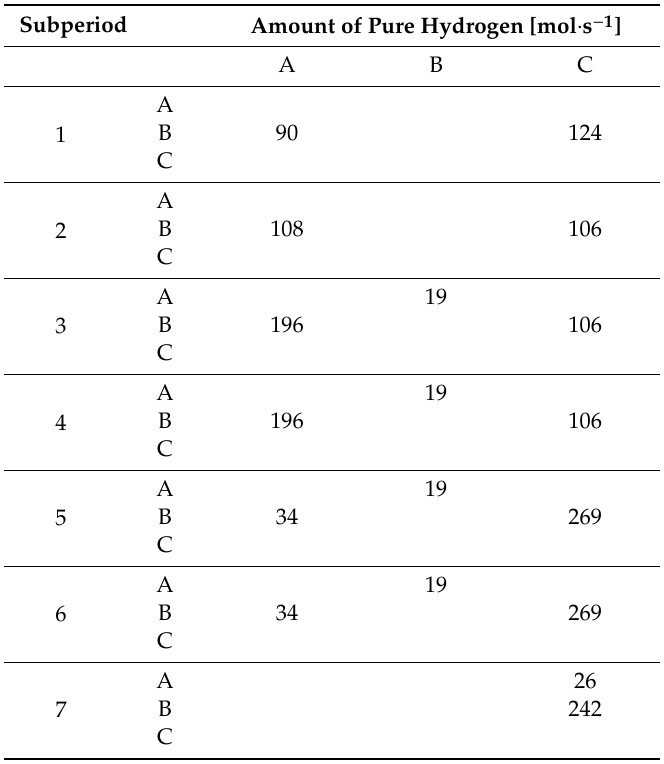
Table 8. The amount of hydrogen exchange among the plants in the structure-fixed